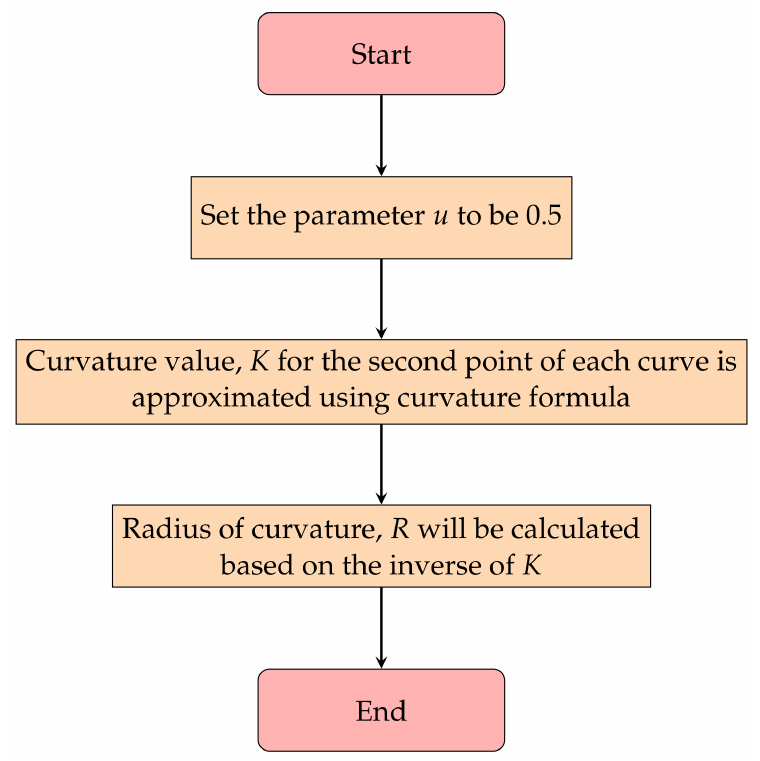
Figure 4. Flowchart for obtaining the curvature values and radius of curvature of the